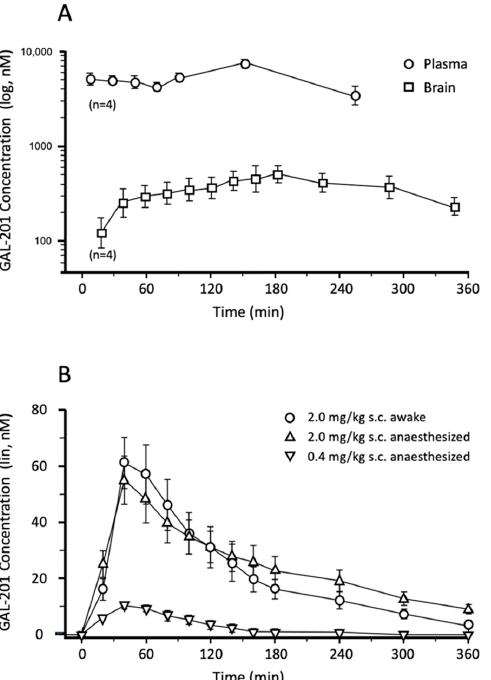
Figure 2. Pharmacokinetics of GAL-201 in rats. ( A ) 50 mg/kg GAL-201 was administered orally to adult male Sprague Dawley rats. A microdialysis probe was placed in the prefrontal cortex to meas- ure the concentration of GAL-201 in the brain interstitial fluid (ISF). Blood samples were collected through a jugular catheter with automated equipment. The animals were able to move freely. Sam- ples were analyzed using HPLC with MS/MS detector. GAL-201 concentrations in ISF dialysate (Brain, squares) and in blood plasma (Plasma, circles) are depicted on a logarithmic scale as means of 4 measurements ±95% confidence limits. ( B ) This experiment was conducted under similar con- ditions as described in panel ( A ). However, GAL-201 was administered as subcutaneous ( s.c. ) injec- tion at doses of 0.4 mg/kg and 2.0 mg/kg. The animals were either anesthetized or awake and freely moving. Microdialysis data are depicted on a linear scale as means of 4 measurements ±SEM). 2.2. Measuring Isolated Neurons Resting Potential The impact of A β 1-42 on an isolated neuron was tested by monitoring the cell resting membrane potential using electrophysiology techniques. Whole cell, perforated patch ex- periments were carried out on isolated neonatal mice hippocampal neurons. A β 1-42 was acutely perfused on a single cell under continuous membrane potential recording. Figure 3A shows two examples of time courses of cell membrane voltage during perfusion (ar- rows) of 50 nM A β 1-42 (left) and the same concentration of A β 1-42 but in the presence of 1 µM of GAL-201 (right). In panel B, averages of resting membrane potential recordings in the different conditions are shown. GAL-201 at a concentration of 1 µM (only tested dose) prevents neuronal cell depolarization, maintaining almost constant the resting membrane potential at the original level.